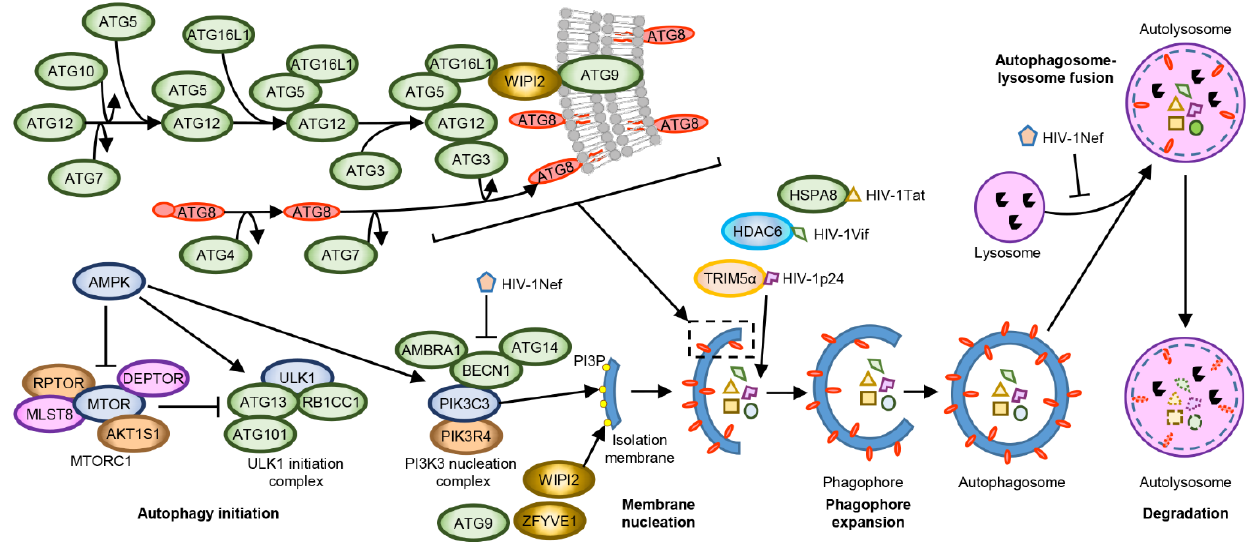
Figure 1. The initiation of autophagy is a multistep process. The main regulators of autophagy are MTOR, an inhibitor, and AMP-activated kinase (AMPK) an activator. MTORC1 inhibition induces autophagy through the formation of the ULK1 complex. This complex initiates the formation of the phagophore by directly activating the phosphatidylinositol 3-kinase catalytic subunit type 3 complex I (PIK3C3 complex). The PIK3C3 complex translocates to endoplasmic reticulum sites and produces phosphatidylinositol 3-phosphate (PI3P) which then recruits PI3P-binding proteins such as WIPI2 and ZFYVE1. HIV-1 Nef can inhibit this process by enhancing the association between BECN1 and its inhibitor BCL2. In the ATG12 conjugation system, ATG12 forms a covalent bond with ATG5, which then binds ATG16L1, followed by dimerization (not shown) and interaction with the PI3P-binding complex. The WIPI2b isoform acts immediately upstream of ATG16L1 and recruits ATG12–ATG5-ATG16L1 to PI3P-containing phagophores. The ATG12–ATG5-ATG16L1 complex